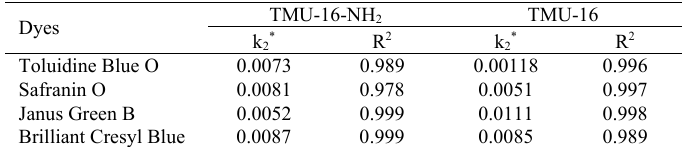
Table 2 Pseudo-second order kinetics parameters for dyes adsorption over TMU-16 and TMU-16-NH . Table 3 Langmuir parameters for the adsorption of dyes over TMU-16 and TMU-16-NH . 2